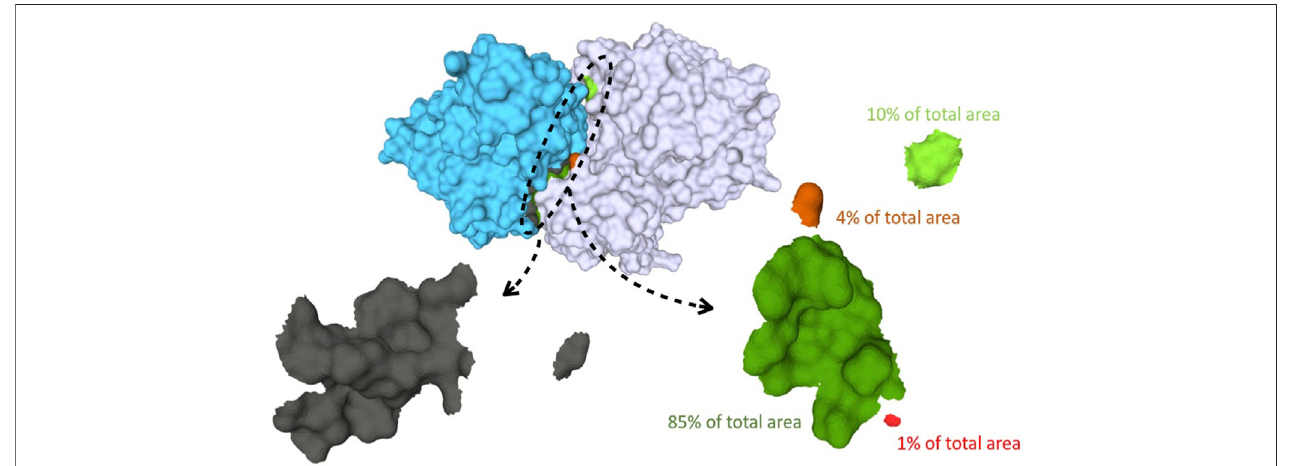
FIGURE 1 | Binding surfaces identi fi cation and separation into connected components for Human Hedgehog acyltransferase in complex with two Fab antibody fragments (pdb code: 7MHY). In cyan the surface of the antibody fragment; in white, the antigen. The paratope, shown in the left bottom, is in gray while the different connected components of the epitope surface are colored in green and red, respectively. On the right: zoom of the epitope surface patches. Each color indicates a distinct connected component of the epitope. Components that are a fraction below 5% of the total contact area are discarded, yielding in this case two residual